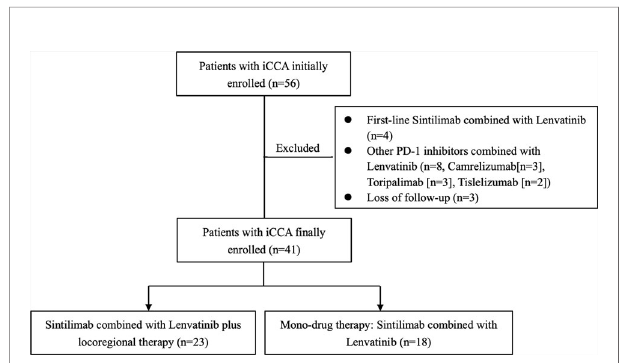
FIGURE 1 | Study pro fi le. iCCA, intrahepatic